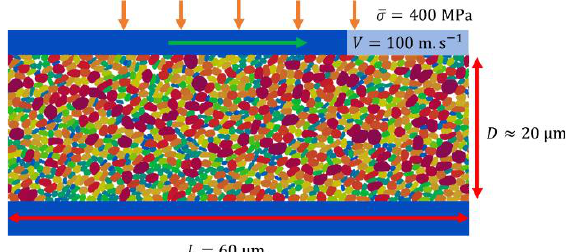
Fig 2. Diagram of third-body simulations made on